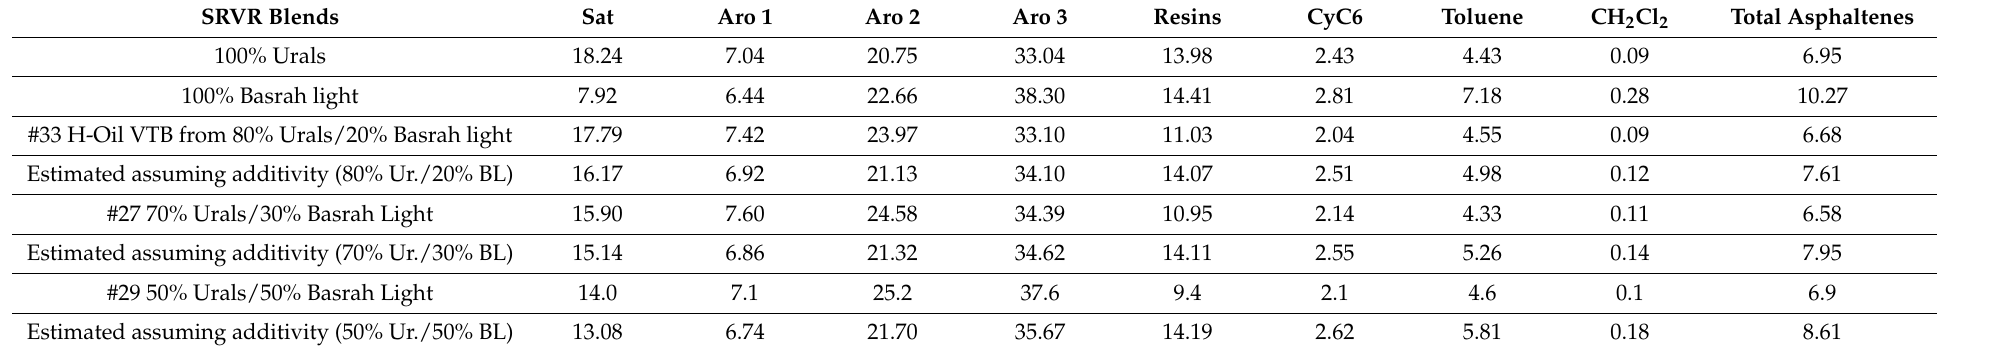
Table 5. Comparison of measured and estimated SAR-AD TM fraction contents using the linear additive rule.